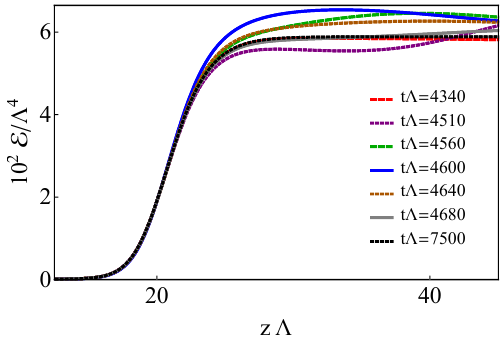
Figure 15 . Same curves as in (cid:12)gure 14 shifted by a constant amount in order to show that the shape of the interface on the left side is hardly modi(cid:12)ed by the bouncing of the perturbation.